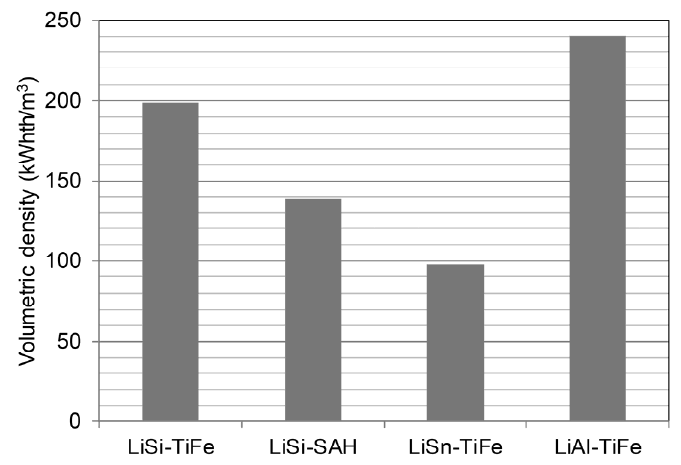
Figure 1. Volumetric energy density of selected Li destabilized thermal energy storage systems.